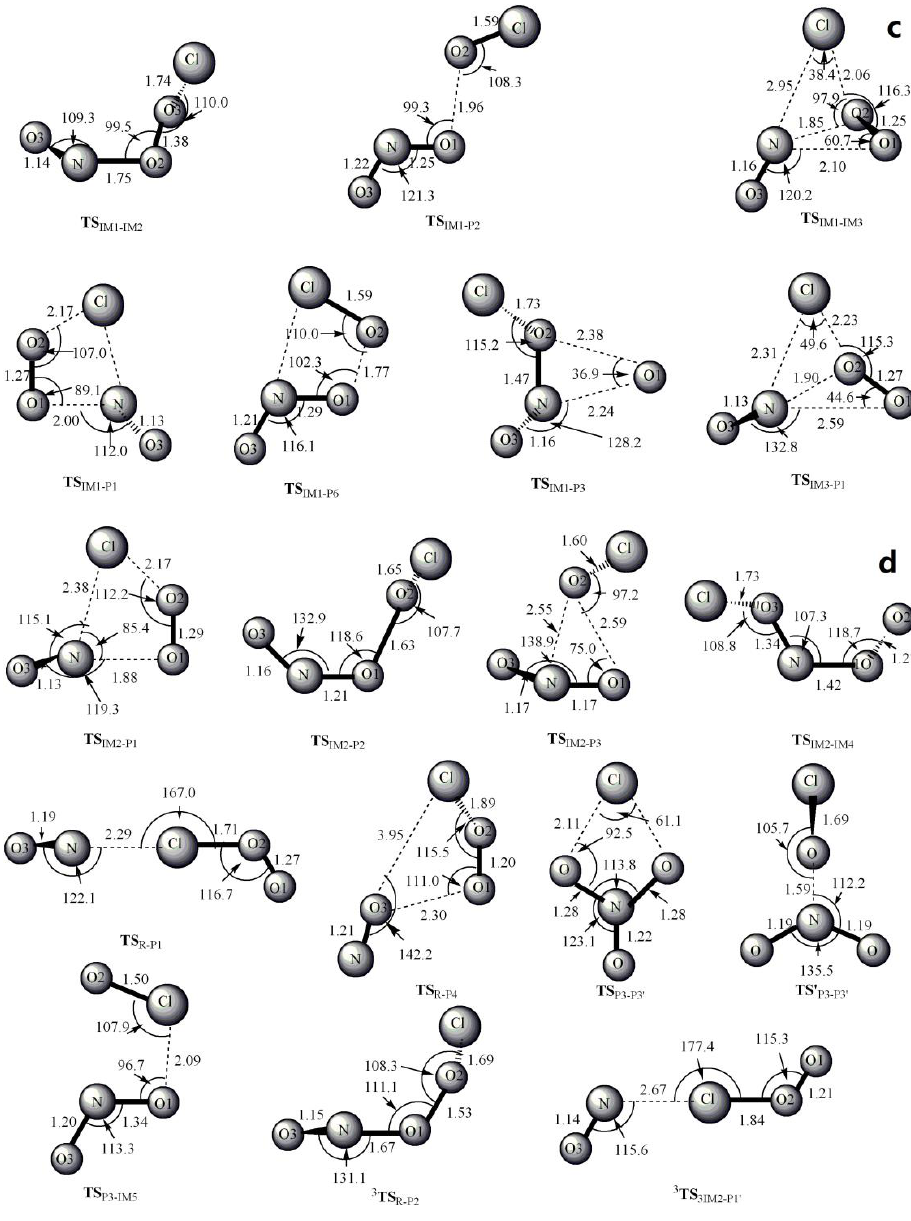
Figure 1. MP2/6-311 + G(2df) optimized geometries for the reactants, products, intermediates (IM) and the corresponding transition states (TS) of ClOO + NO reaction. The values in parentheses are the pertinent experimental data from the literature [48 – 51] and ( a – d ) represent refs [48 – 51], respectively. Bond lengths are in Å and bond angles are in